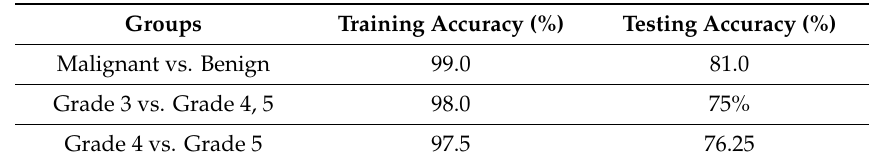
Table 6. Evaluation results for three binary divisions using the multilayer perceptron (MLP) classification technique.